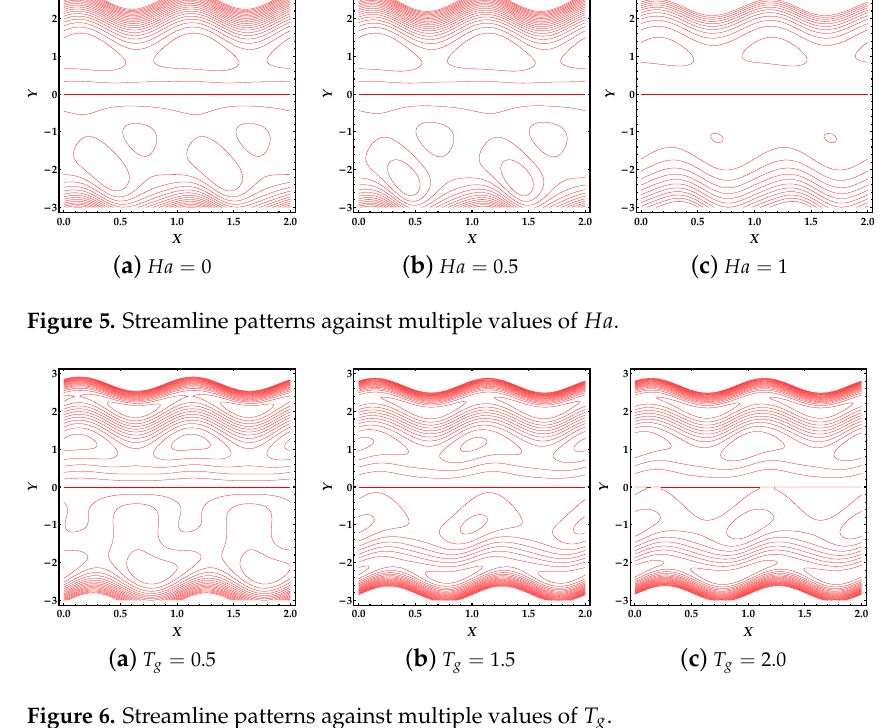
Figure 6. Streamline patterns against multiple values of T g